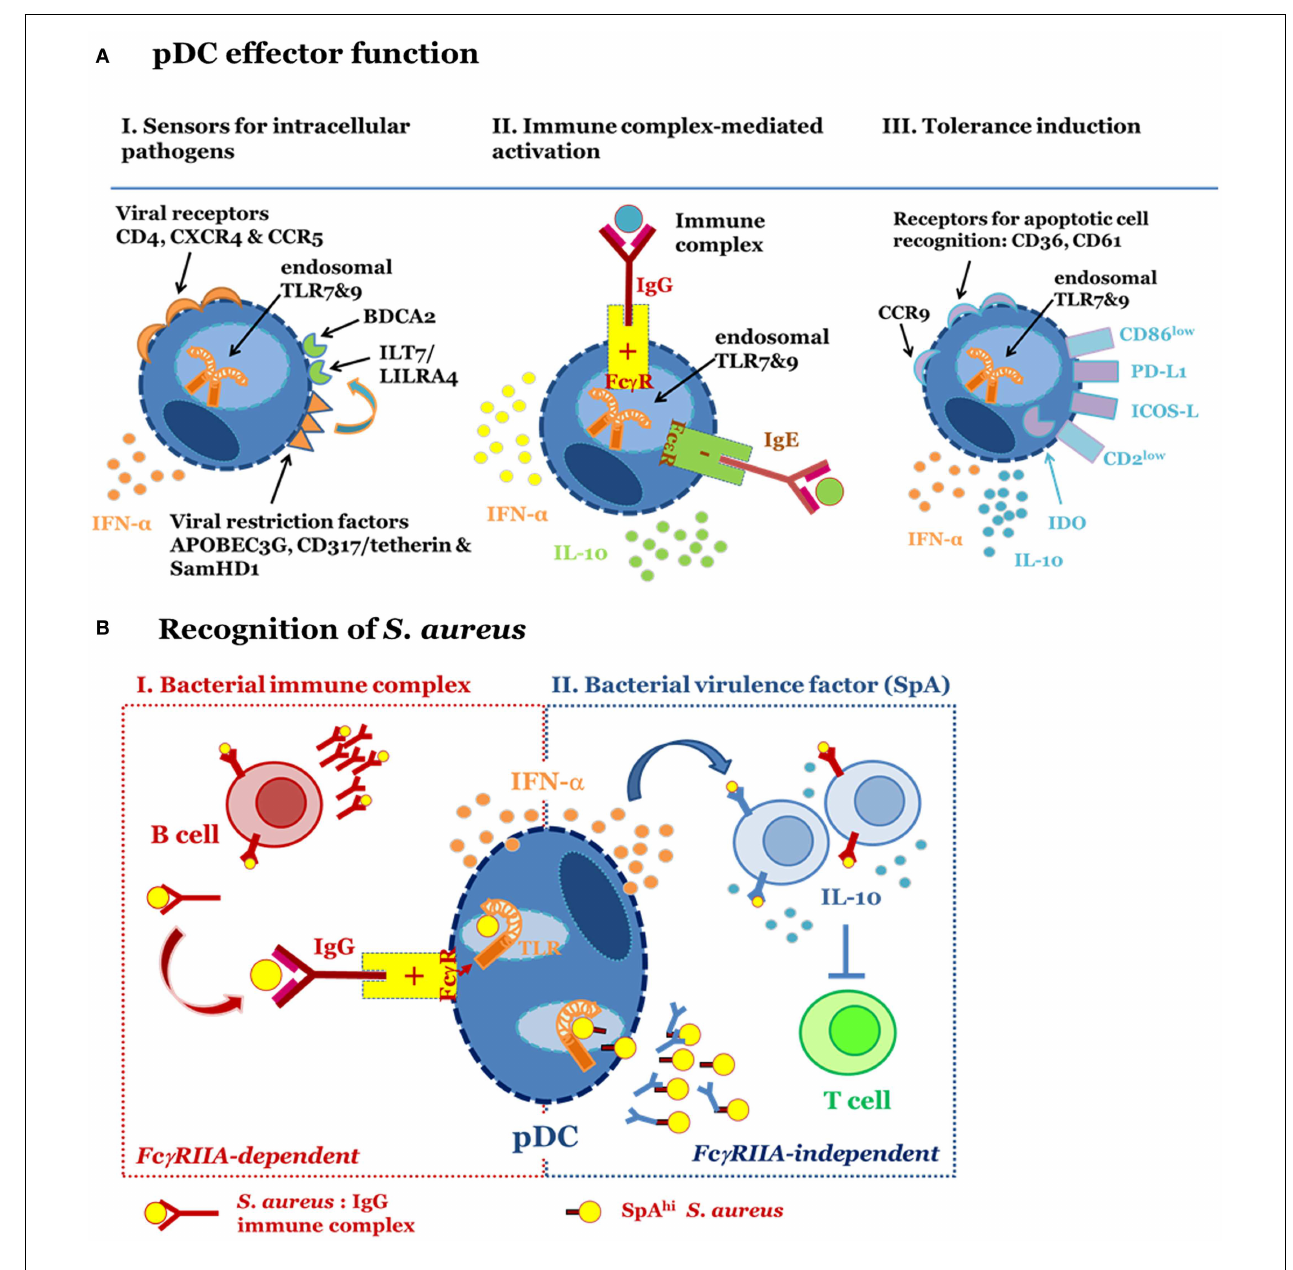
CD86 expression, release of IL-10, expression of CCR9, IDO, ICOS-L, and low CD2. Expression of CD36 and CD61 among other surface receptors enables apoptotic cell recognition. (B) S. aureus -induced pDC activation occurs in an Fc γ RIIA-dependent (I) and -independent (II) fashion. I (left): pDC are activated by bacterial immune complexes (IC) with anti-staphylococcal IgG.This activation requires prior generation of IgG and therefore forms part which induces secretion of IFN- α . II (right): S. aureus strains expressing high levels of protein A (SpA) stimulate pDC in the absence of IgG and